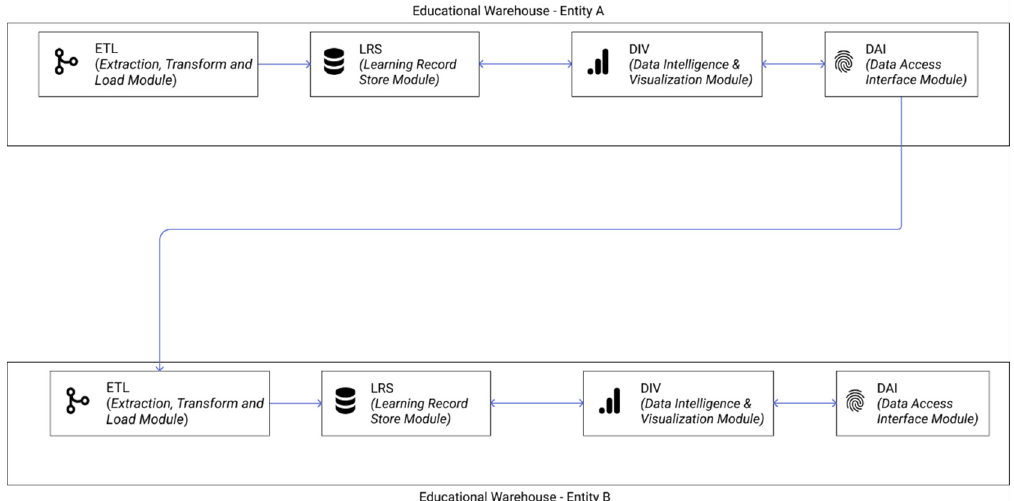
Figure 2. Interinstitutional use of an educational warehouse: data are exchanged between entity A and entity B, where entity A’s Data Access Interface (DAI) is the data origin of Entity B’s Extract, Transform and Load